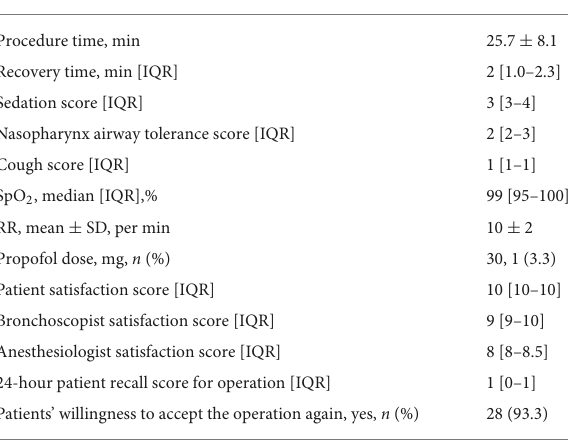
TABLE 4 Procedure data, propofol dosage and satisfaction ( n = 30).